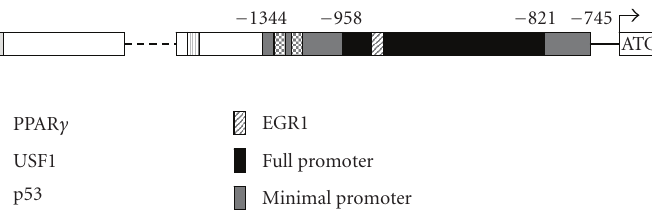
Figure 2: PTEN promoter and its transcription factors. PTEN ’s full-length promoter lies between − 1344 and − 745 (gray bar), while the minimal promoter lies between − 958 and − 821 (black bar). Four transcription factors are known to directly bind upstream of PTEN: PPAR γ (solid gray bar), USF1 (stripped gray bar), p53 (dotted gray bar), and EGR1 (dashed gray